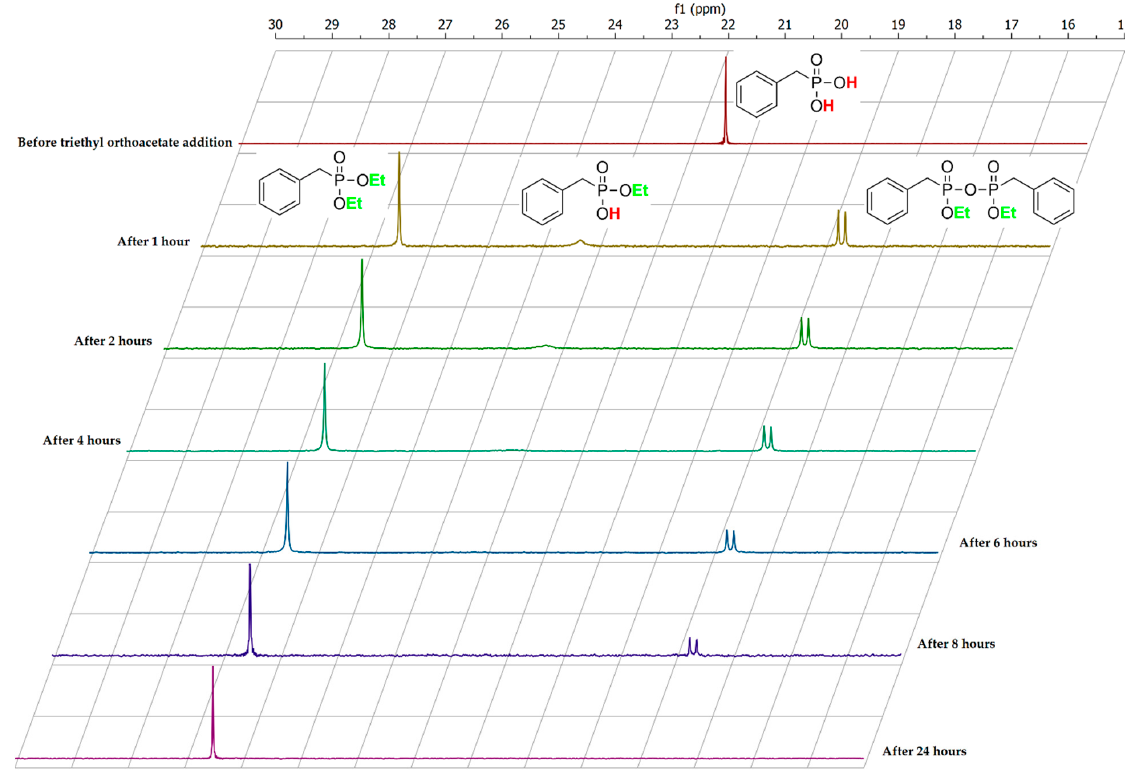
Figure 2. 31 P NMR spectrum of substrate 1b stacked with spectra of reaction mixture recorded during the course of the reaction.